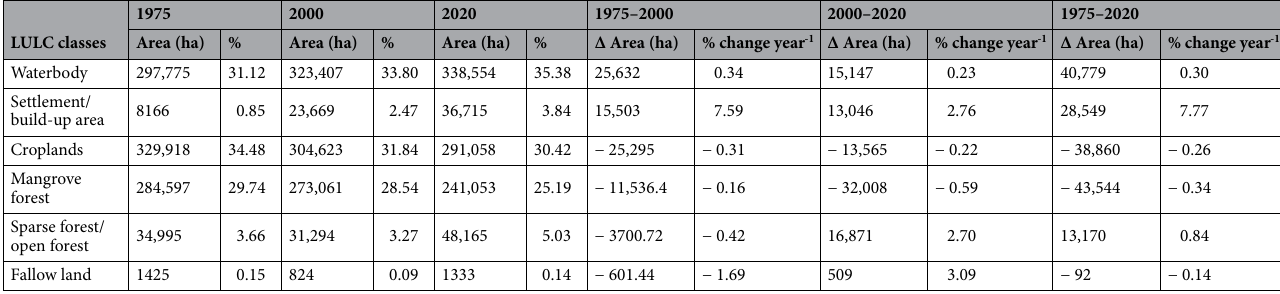
Table 1. Changing pattern of LULC within the study